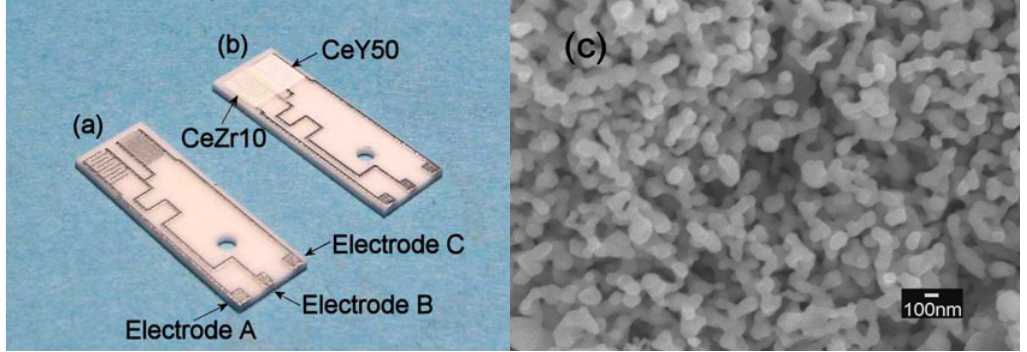
Figure 6. Fabricated sensor element. (a) Electrode patterns for the sensor material and the temperature compensating material on one substrate with a size of 15  5 mm 2 . (b) Overview of the sensor element, comprised of thick films of the sensor material and the temperature compensating material. (c) SEM image of the CeY50 (Ce sample